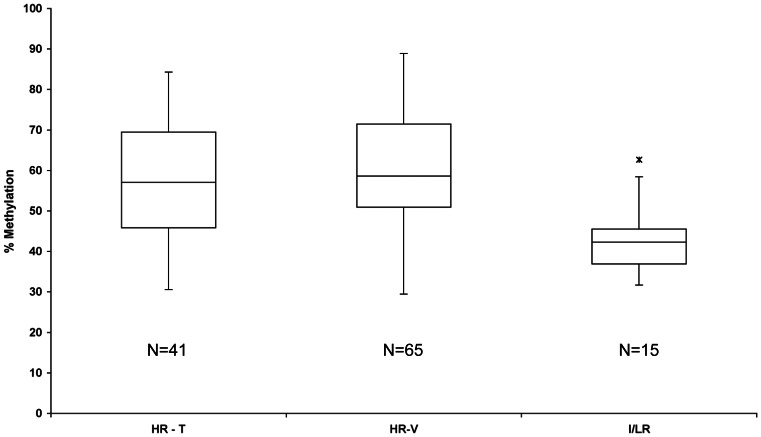
Distribution of methylation values for PCDHB cluster in high-risk patients subdivided in training (HR-T) and validation (HR-V) and compared with intermediate and low-risk patients (I/LR).The lower and upper boundaries of each box are the 25th and 75th percentile. Black bars represent median values; wiskers are the smallest and largest values that are not outliers (defined as larger than 1.5 and smaller than 3 box lengths from 25th and 75th percentiles). The black star is the upper outlier.